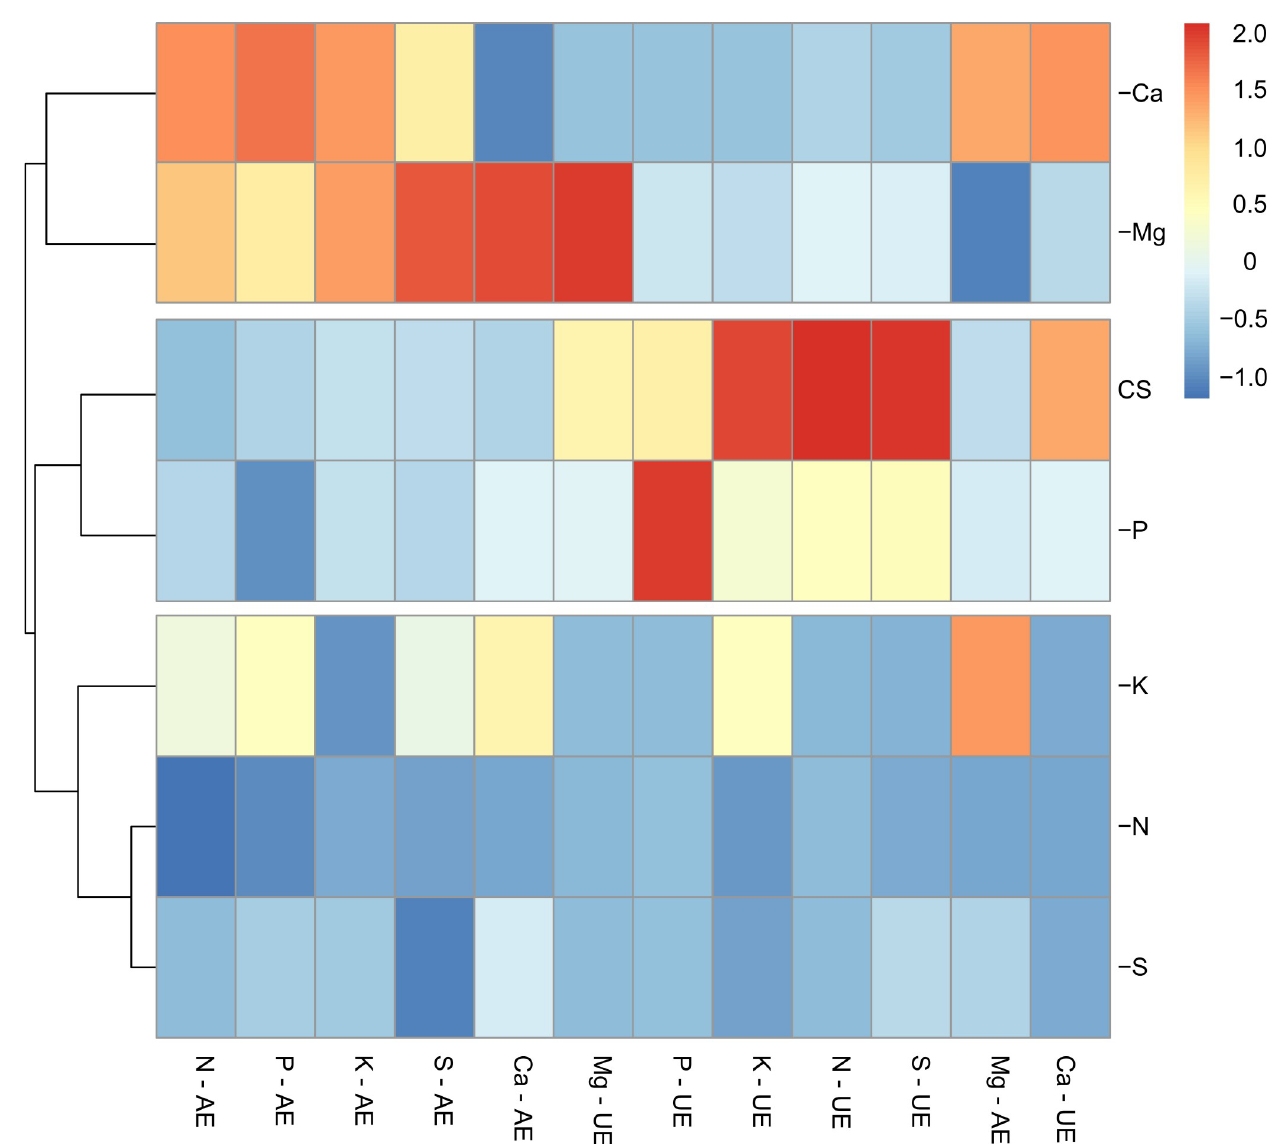
Fig 8. Hierarchical cluster analysis with standardized data on absorption efficiencies (EA) and use (EU) of macronutrients in scarlet eggplants under nitrogen (-N), phosphorus (-P), potassium (-K), calcium deficiency (-Ca), magnesium (-Mg) and sulfur (-S) and complete solution (CS).